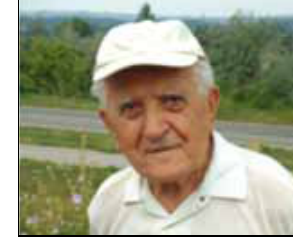
Figure 1: Ferenc Pohl, former chief gardener of Debrecen